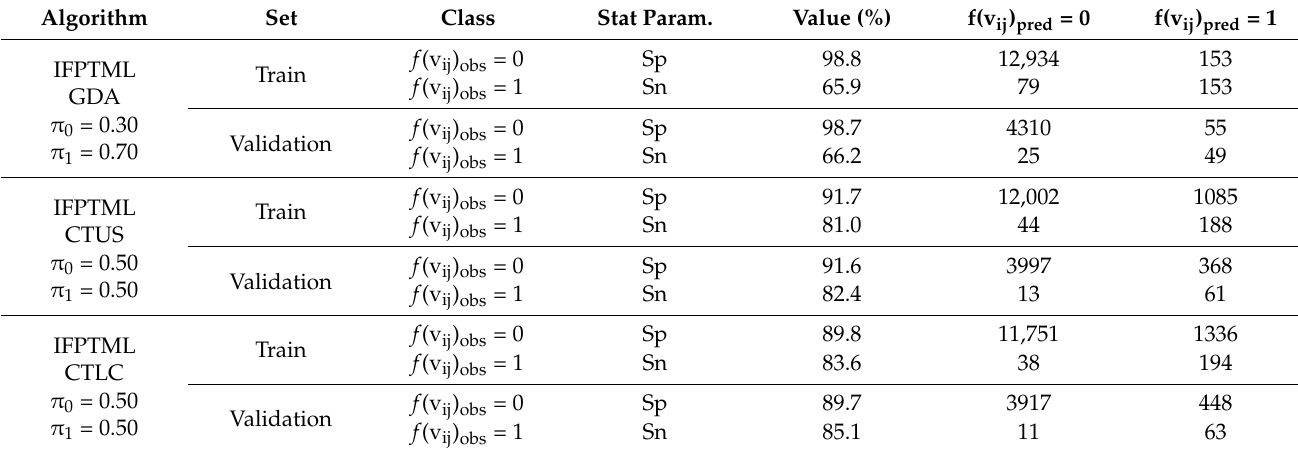
Table 5. Comparison of models with different